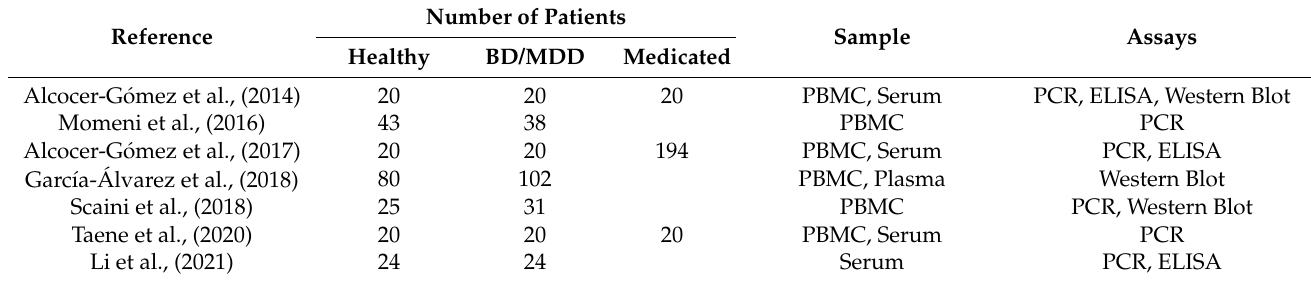
Table 1. Neuropsychiatric Studies Investigating NLRP3 Inflammasome Activation in Mood Disorders. Seven articles [24–30] investigated NLRP3 inflammasome activation in patients suffering from bipolar disorder and major depressive disorder. All studies use PCR, assay ELISA, or Western blotting to measure mRNA and protein expression in human blood samples containing either PBMC, serum, or plasma.